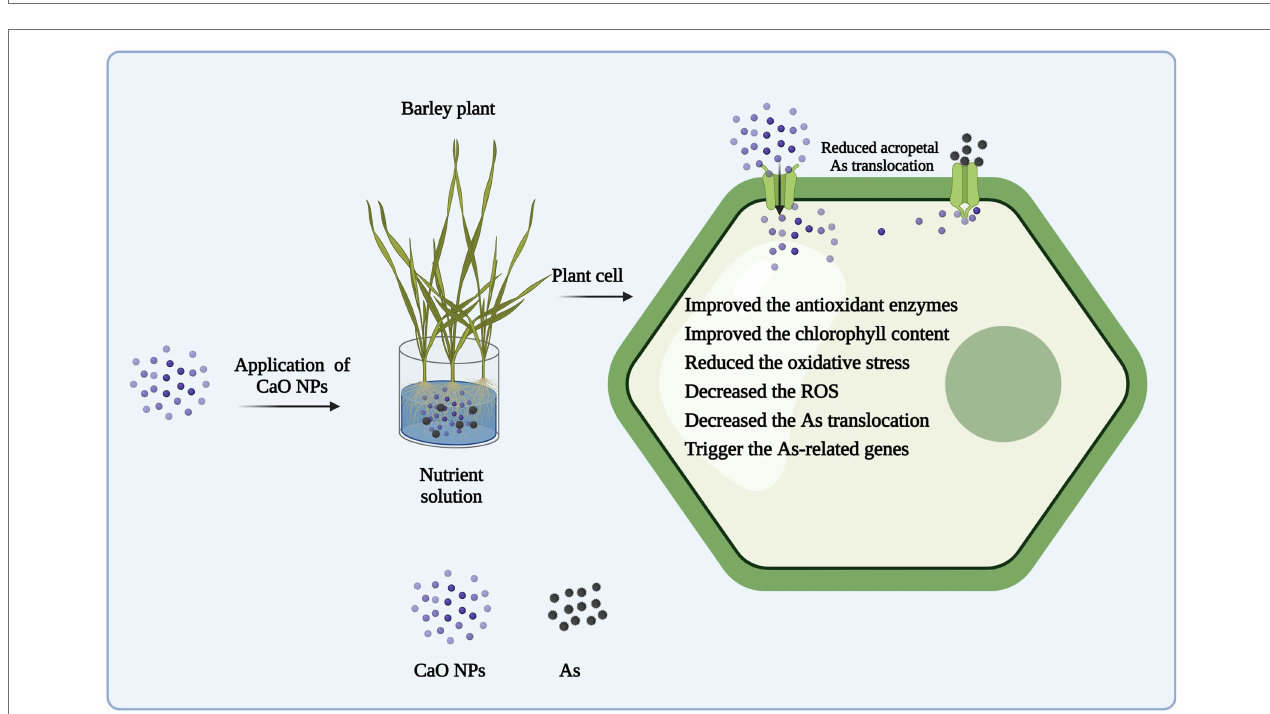
FIGURE 7 | Relative expression of barley phosphate transporter genes (A) HvPHT1.1 , (B) HvPHT1.3 , (C) HvPHT1.4 , and (D) HvPHT 1.6 in roots under As stress. Different letters above error bars indicate the significant difference between treatments and genotypes at p ≤ 0.05.